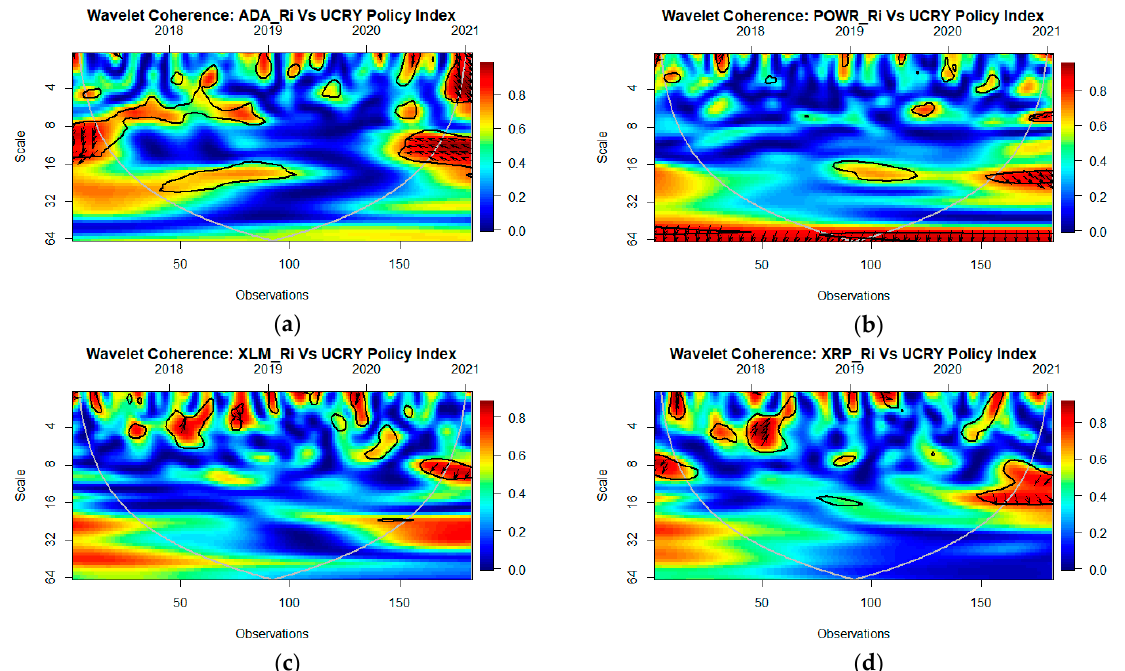
Figure 4. Wavelet coherence between sustainable cryptos and UCRY policy index. Note: ( a ) = wavelet coherence between Cardano and UCYR Policy Index, ( b ) = wavelet coherence between Powerledger and UCYR Policy Index, ( c ) = wavelet coherence between Stellar and UCYR Policy Index, ( d ) = wavelet coherence between Ripple and UCYR Policy Index.